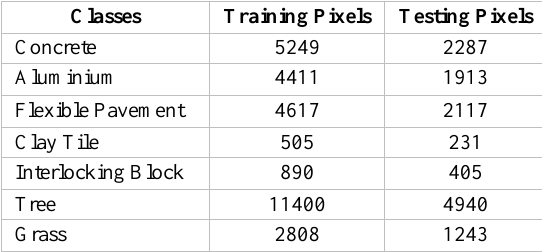
Table 2: Training and testing pixels used for